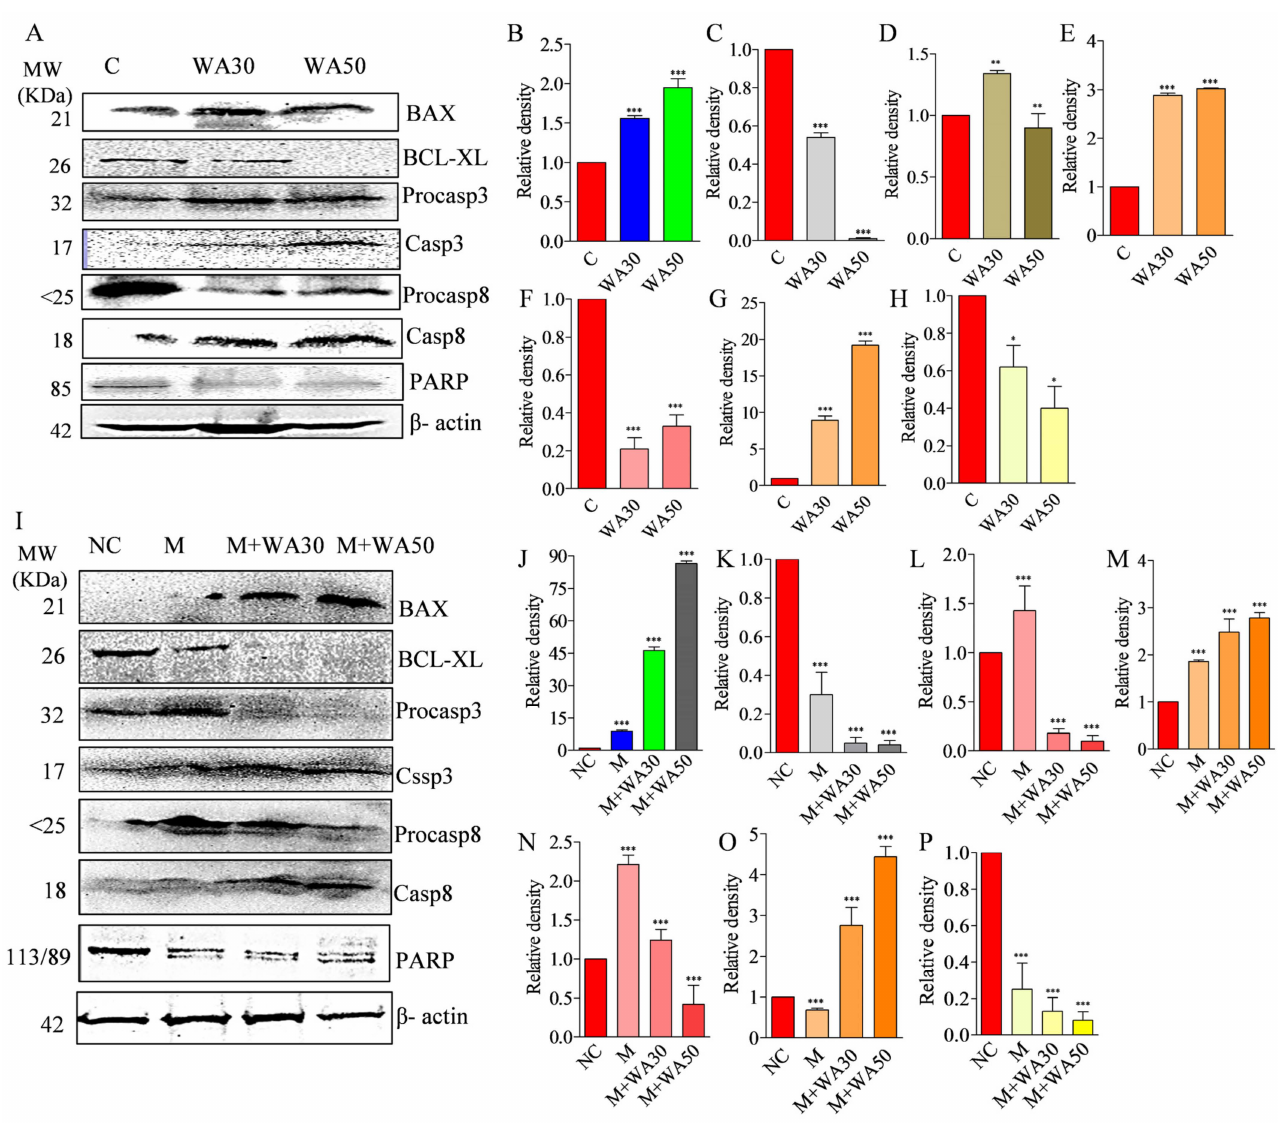
Figure 7. The effect of Withaferin A, miR-181c-5p mimic, and their co-treatment on apoptosis-related protein markers in triple-negative breast cancer cells. ( A ) Protein expression level of BAX; BCL-XL; Procaspase 3, 8; Cleaved caspase 3, 8; and PARP in WA IC 30 and IC 50 concentration treated MDA- MB-231 cells in 24 h. Relative densities of immuno bands of ( B ) BAX, ( C ) BCL-XL, ( D ) Procaspase 3, ( E ) Cleaved caspase 3, ( F ) Procaspase 8, ( G ) Cleaved caspase 8, and ( H ) PARP were estimated by image lab software 6.0.1 Bio-Rad. ( I ) Protein expression level of BAX; BCL-XL; Procaspase 3, 8; Cleaved caspase 3, 8; and PARP in miR-181c-5p mimic transfected and mimic + WA (IC 30 and IC 50 ) co-treated MDA-MB-231 cells in 24 h. Relative densities of the immuno bands of ( J )